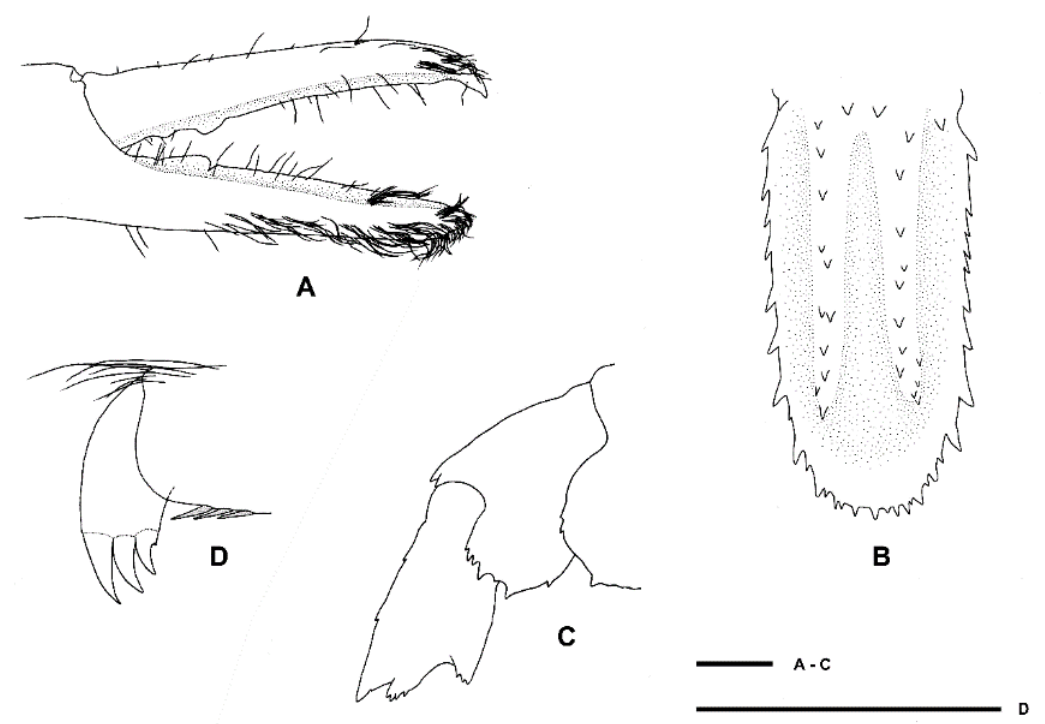
Figure 25. Spongiocaris yaldwyni Bruce & Baba, 1973 [21], F (NIWA 82821). ( A ) Fingers of left P3, mesial view. ( B ) Telson, dorsal view. ( C ) Fourth to sixth pleura, lateral view. ( D ) Dactylus of left P5, lateral view. Scale bars = 1 mm.